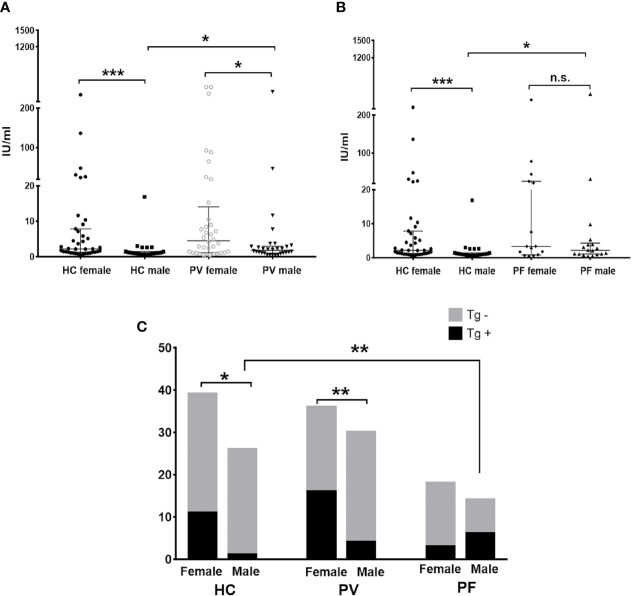
The status of anti-Tg antibody in PV patients, PF patients and healthy controls. (A, B) The levels of anti-Tg antibody in PV patients, PF patients and healthy controls, shown as median with interquartile range. (C) The antibody positivity of anti-Tg antibody in PV patients, PF patients and healthy controls. * indicates a significant difference (*p < 0.05, **p < 0.01, ***p < 0.001, by the Mann-Whitney U test for the comparison of antibody levels and The Fisher’s exact test for the comparison of antibody positivity).